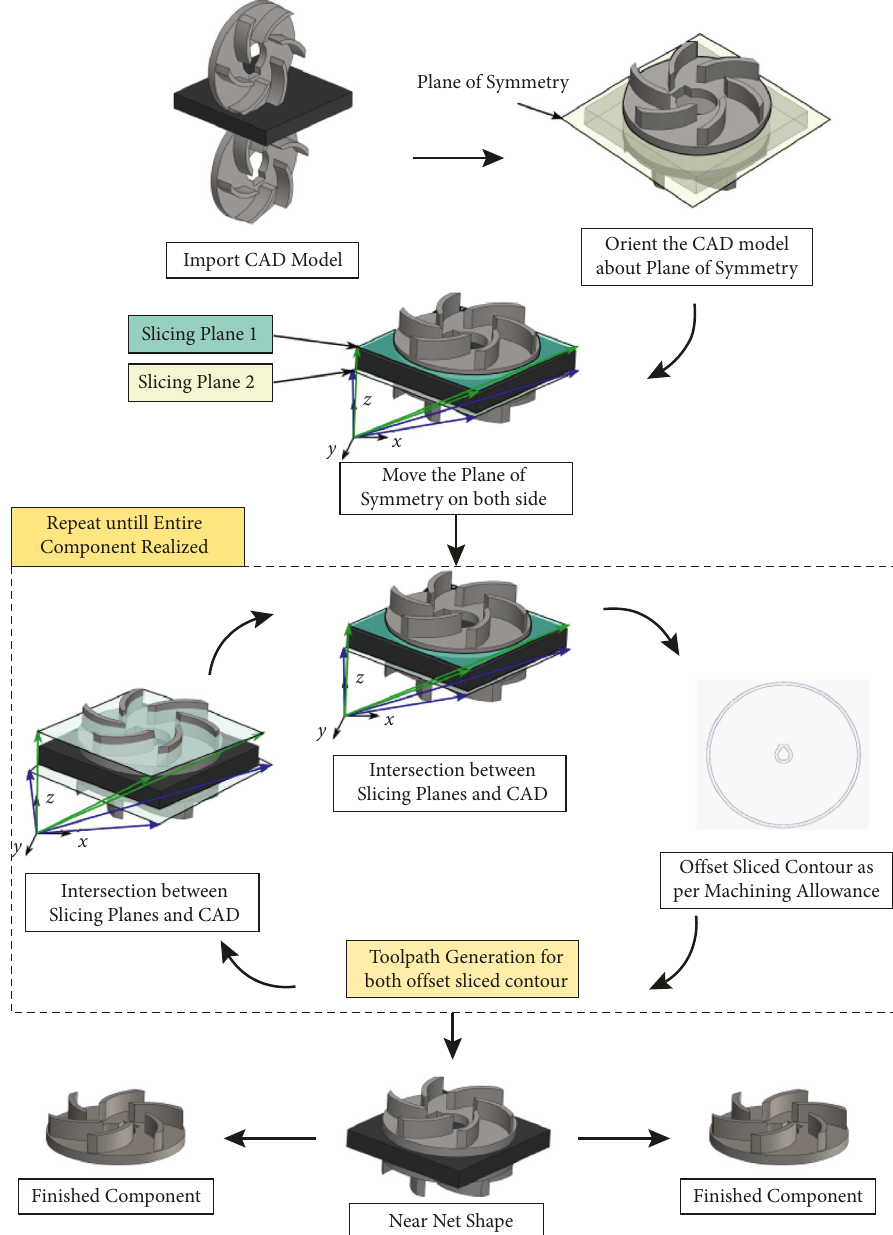
Figure 26: Process flow for integrated